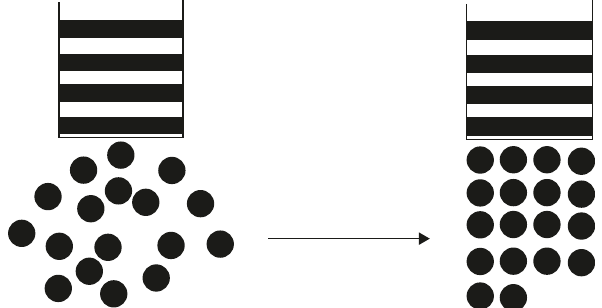
Figure 8: Diagram of pedestrians dispersion time